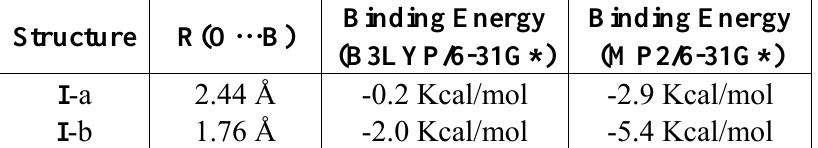
Table 1. The optimal bonding distance (Å) and binding energies with the basis set superposition error (BSSE) corrections for  - D -glucose pentaacetate.